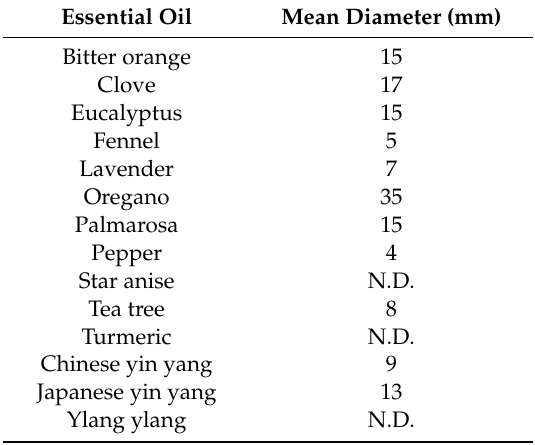
Table 2. Results of antiyeast activity of 14 essential oils using the solid medium di ff usion assay. Essential Oil